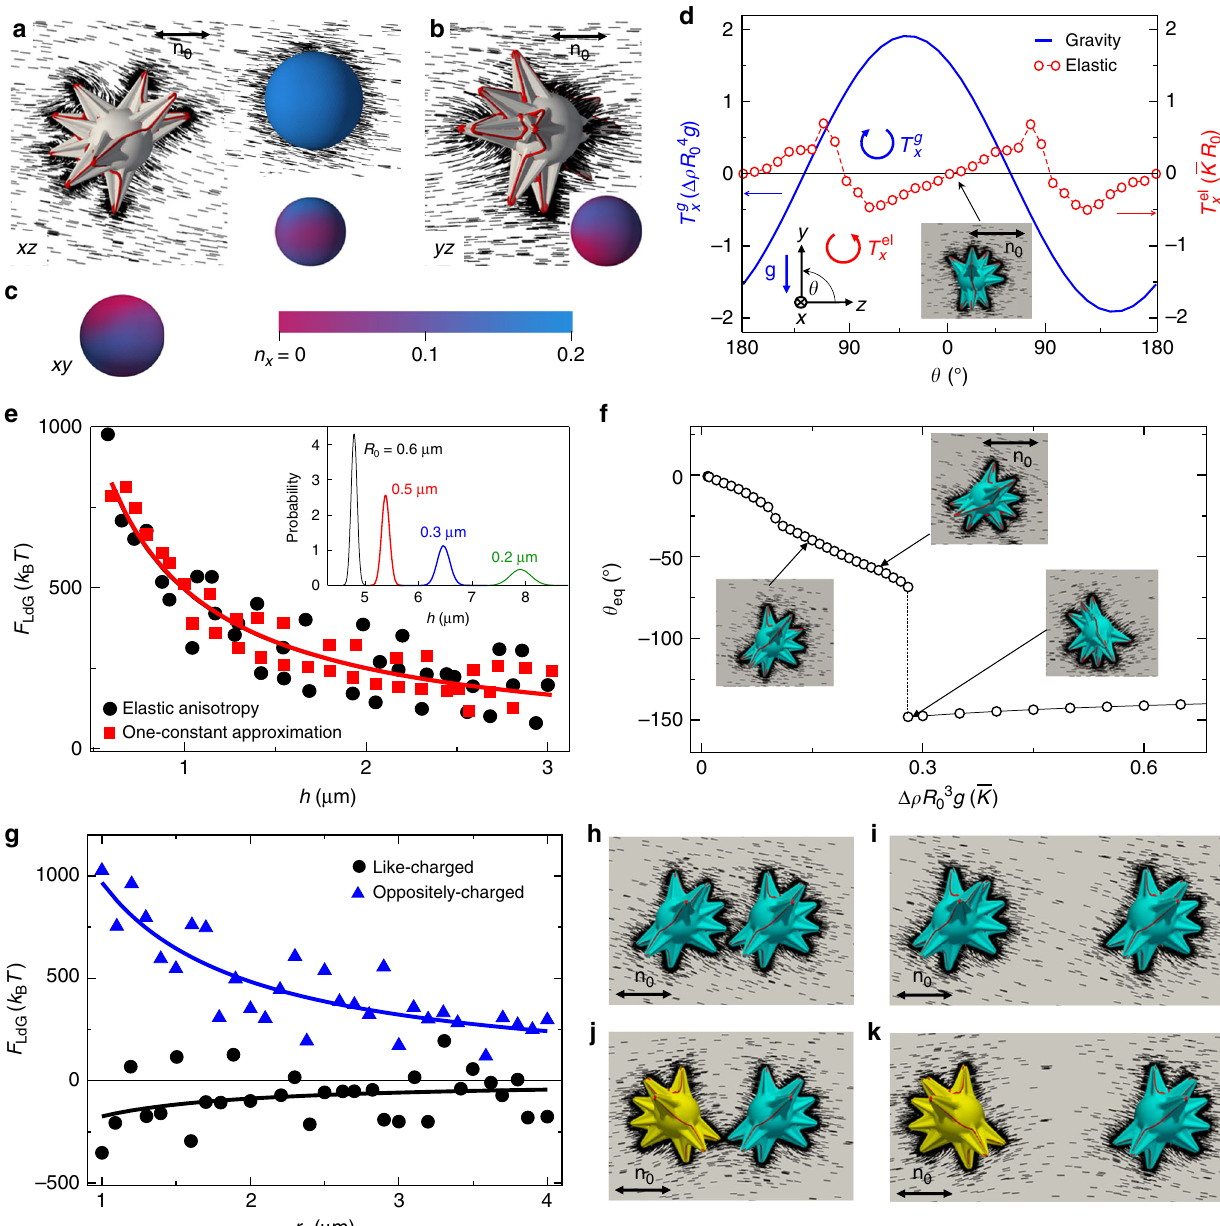
Fig. 5 Orientation, effective repulsion from a wall and pairwise interactions of monopoles. a , b Director structures around a meso fl ower with a dominant elastic monopole. n ( r ) is shown by black rods and defect lines are depicted as red tubes. As a comparison, n ( r ) induced by a pure idealized monopole is shown as the top-right inset of a whereas the bottom-right insets in a , b show color-coded diagrams of n x on the interpolation sphere surrounding the meso fl ower when viewed from different directions. The coordinate system is set so that n 0 || z . c , The xy perspective view of the n x and the color-coded scale of n x . d Elastic (red circles) and gravity (blue line) torques about the center of the particle core (Supplementary Figs. 5 and 6) versus θ . The gravity acts in the negative y -direction; g is the gravitational acceleration. The meso fl ower is placed above a wall with fi xed planar boundary conditions along z and distance from the wall h = 3.5 R 0 . Balance of the two torques occurs at an equilibrium orientation θ eq , which is plotted in f versus Δ ρ R 0 3 g . e , Reduced Landau-de-Gennes free energy F LdG versus h at θ = − 40°. Black solid circles correspond to K 11 = K 33 = 2 K 22 = 7.8 pN and red solid squares to the one- constant approximation K 11 ¼ K 33 ¼ K 22 ¼ (cid:1) K ; we use T = 298 K and R 0 = 0.2 μ m in the minimization. The inset in e shows the probability distribution / exp ð(cid:2)ð F þ E Þ = k T Þ of the particle-wall separation h for several values of R 0 indicated next to the curves. For the Landau-de Gennes free energy we g LdG B ¼ 5 : 659 h (cid:2) 1 (cid:1) KR 2 use F (parameters extracted from the black fi tting curve in e ), and E g is the particle gravitational energy ∝ h ; average elastic constant 0 LdG (cid:1) K ¼ 6 : 5 pN , and T = 298 K. g F LdG versus separation distance r c between a pair of like (black solid circles) and opposite (blue solid triangles) monopoles at h = 20 R 0 θ 1 = θ 2 = 40° for like monopoles and θ 1 = 40°, θ 2 = − 40° for opposite monopoles. Lines in e , g are fi tting curves with the function f ( x ) ∝ 1/ x . Director structures around pairs of like-charged h , i and oppositely-charged j , k monopole particles at r c = 5 R 0 in h , j and r c = 10 R 0 in i , k